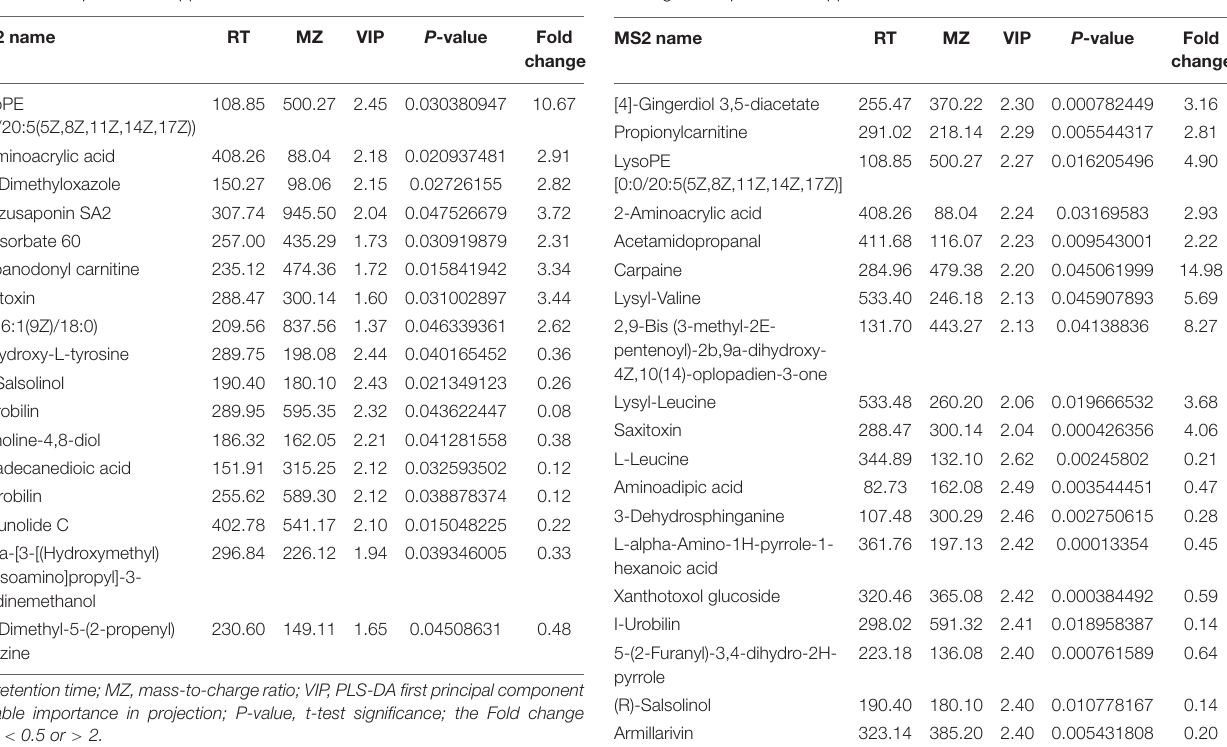
TABLE 3 | The top 20 most significantly changed metabolites in GDM rats treated with high-dose probiotics supplements vs. GDM